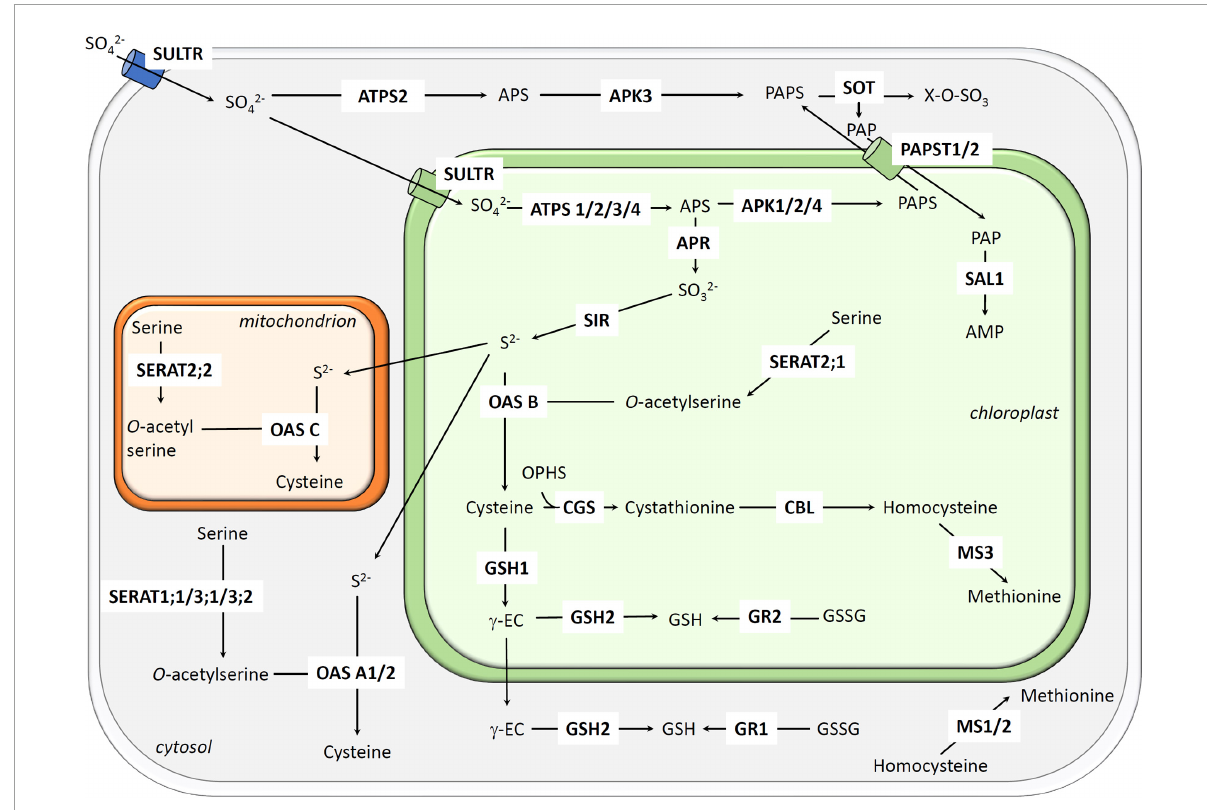
FIGURE1 Subcellular localizations and reactions catalyzed by enzymes involved in sulfate assimilation and cysteine, methionine, and glutathione synthesis. Abbreviations of proteins (in bold) are as follows: ATPS, ATP-sulfurylase; APK, APS kinase; APR, APS reductase; CBL, cystathionine β -lyase; CGS, cystathionine γ -synthase; GSH1, γ -glutamate cysteine ligase; GSH2, glutathione synthetase; GR, glutathione reductase; MS, methionine synthase; OAS, o-acetylserine (thiol) lyase; PAPST, phosphosulfate transporter; SERAT, serine acetyltransferase; SIR, sulfite reductase; SOT, sulfotransferase; SULTR; sulfate transporter. Abbreviations of metabolites are as follows: AMP, adenosine monophosphate; APS, adenosine 5 (cid:48) -phosphosulfate; OPHS, o -phosphohomoserine; PAP, 3 (cid:48) -phosphoadenosine 5 (cid:48) -phosphate; PAPS, 3 (cid:48) -phosphoadenosine 5 (cid:48) -phosphosulfate; SO 42 - : sulfate, SO 32 - : sulfite, S 2 - : sulfide; γ -EC, γ -glutamyl cysteine; X-O-SO 3 : sulfated compound.